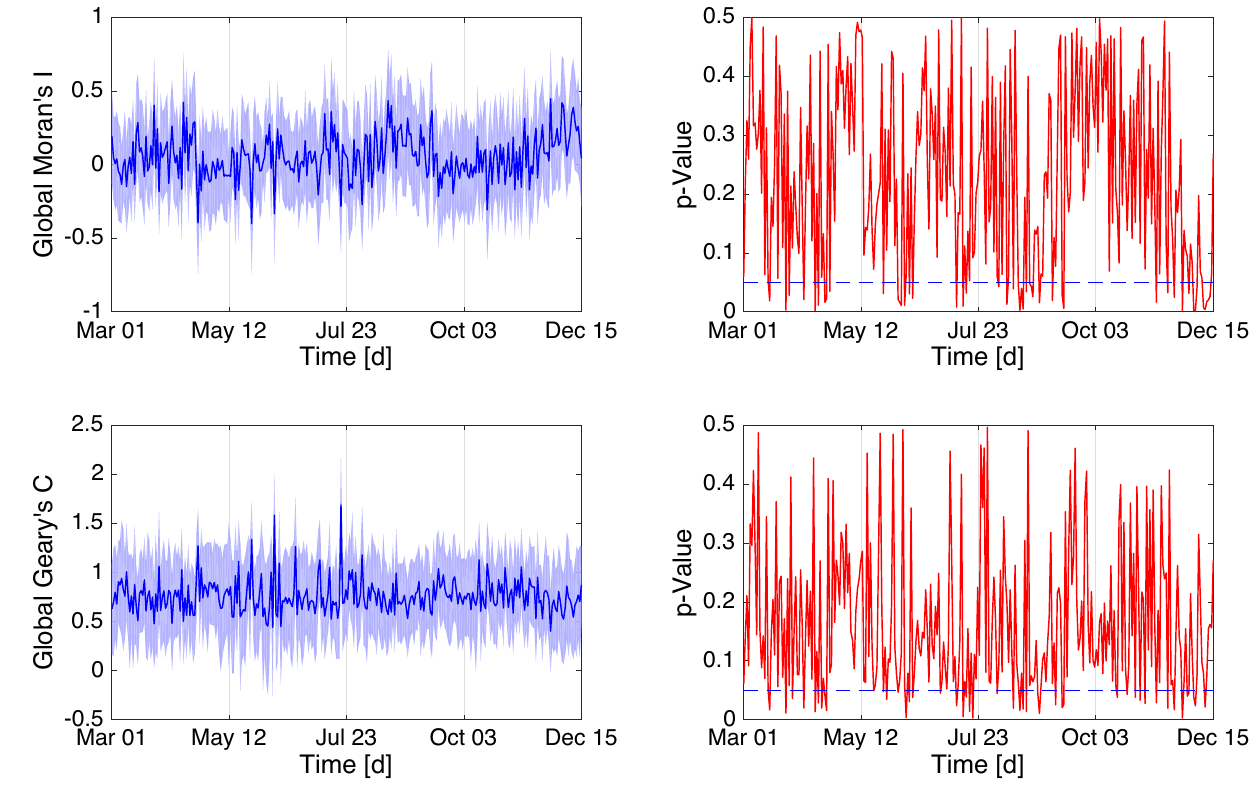
Figure 5. Global Moran’s I and Geary’s C computed on a daily basis together with the corresponding 95% confidence interval and p-Value (right) for significance. The blue dashed line represents the significance level α = 0.05 .